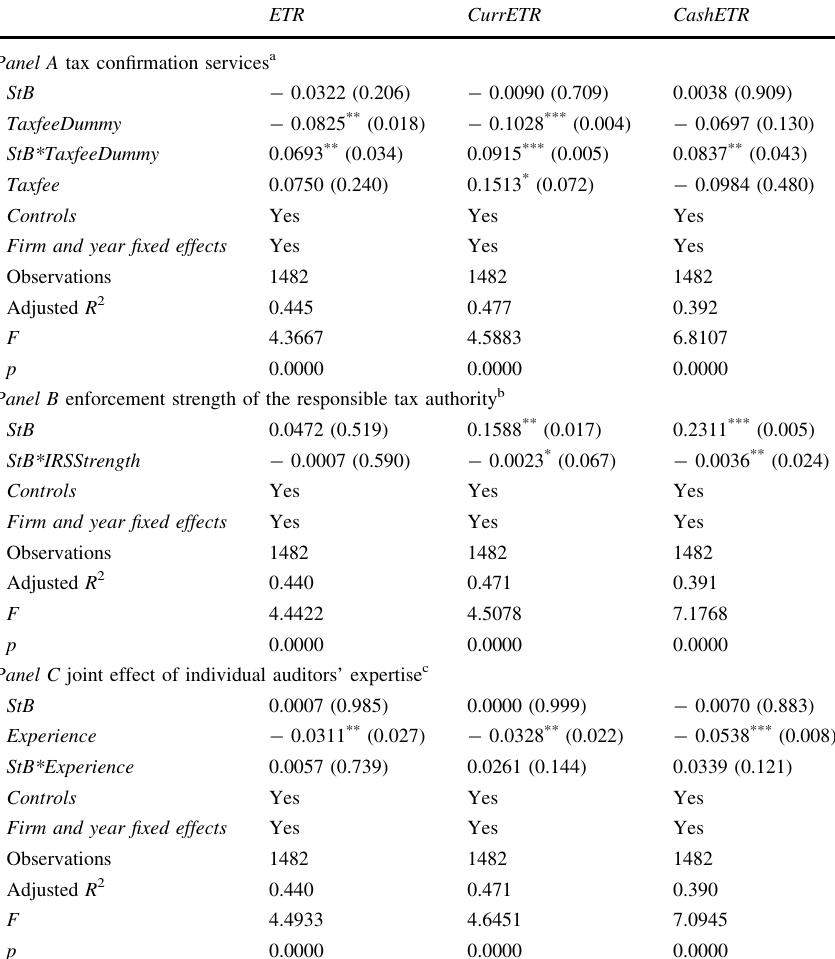
Table 7 Robustness checks—knowledge spillover